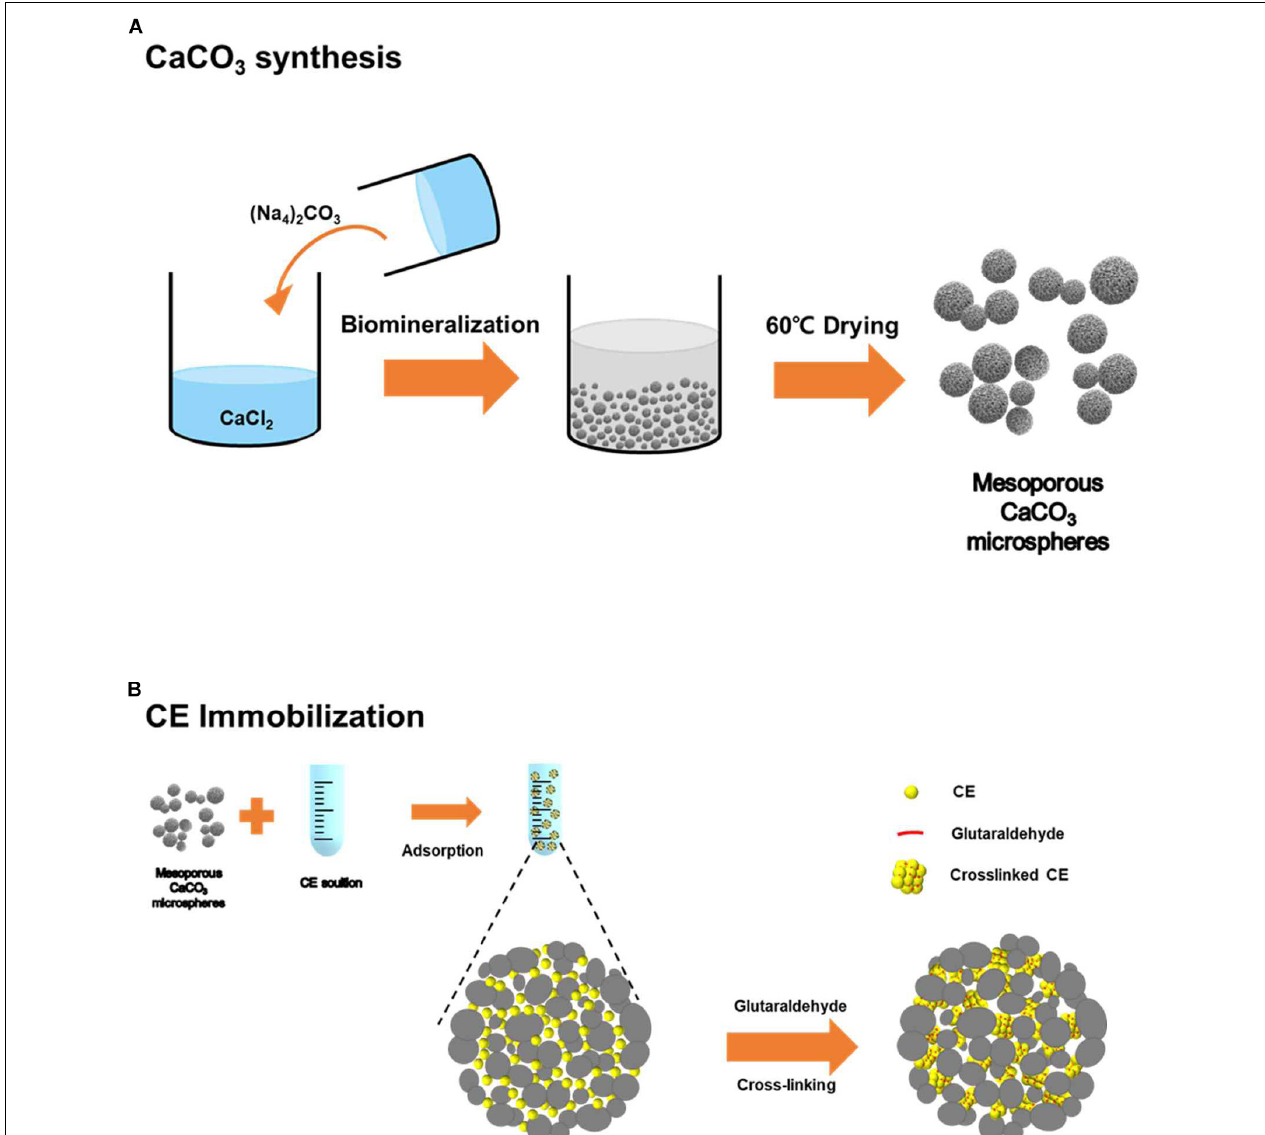
FIGURE 1 | Schematic illustrations of (A) CaCO 3 microsphere preparation and (B) enzyme